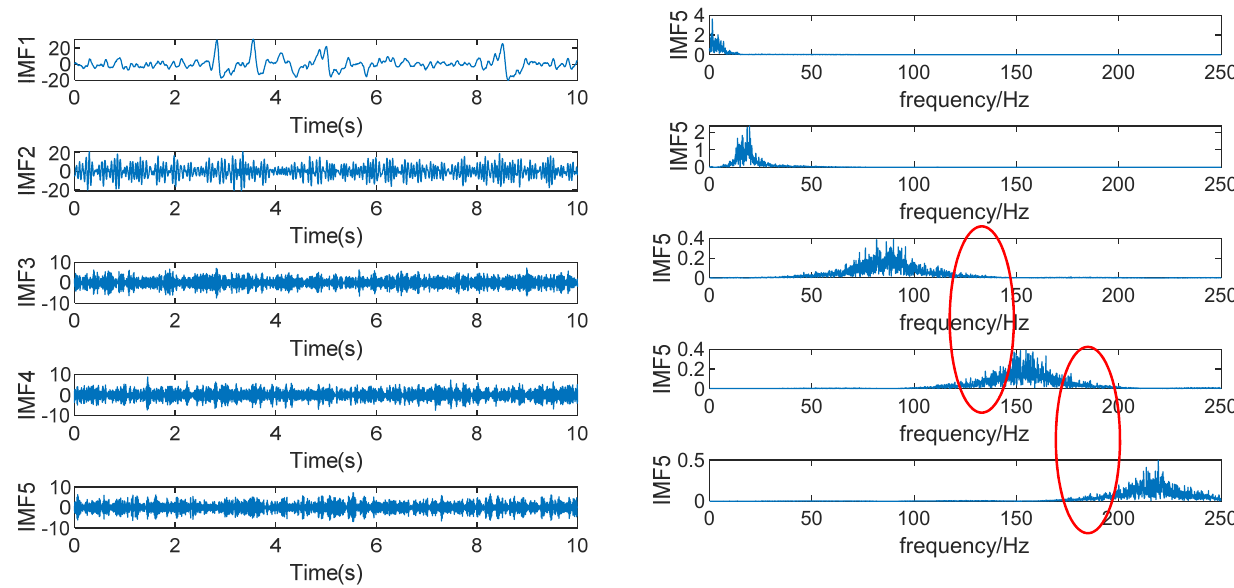
Figure 7. VMD decomposition result of K = 5 .